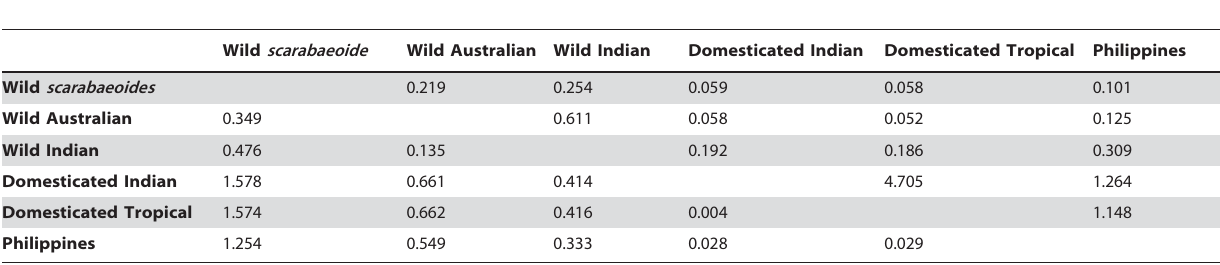
Table 4. Pairwise estimates of Nei’s genetic distance (lower diagonal) and gene flow (Nm) values (upper diagonal) among wild and domesticated